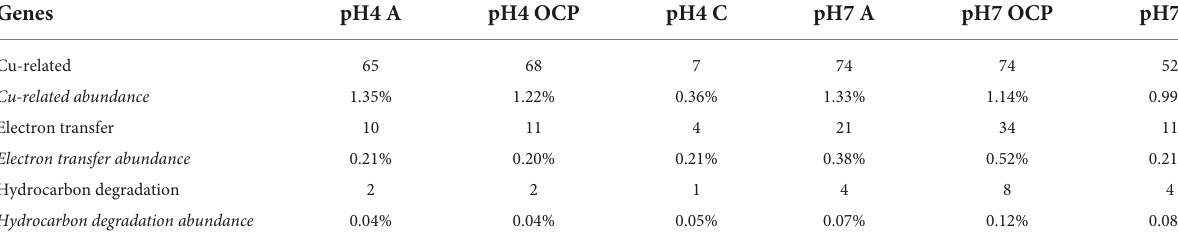
TABLE 1 Gene count and abundance for the three pathways in all